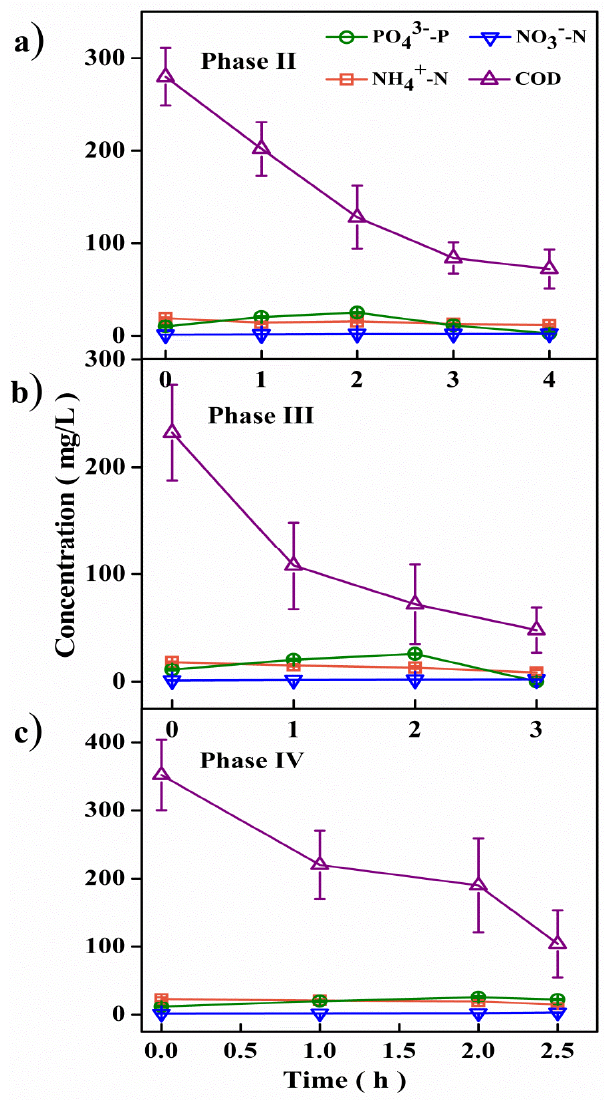
Figure 3. The concentration of various nutrients in typical cycle profiles for ( a ) phase II, ( b ) phase III, and ( c ) phase IV. Error bars indicate the standard deviations of the measurements.